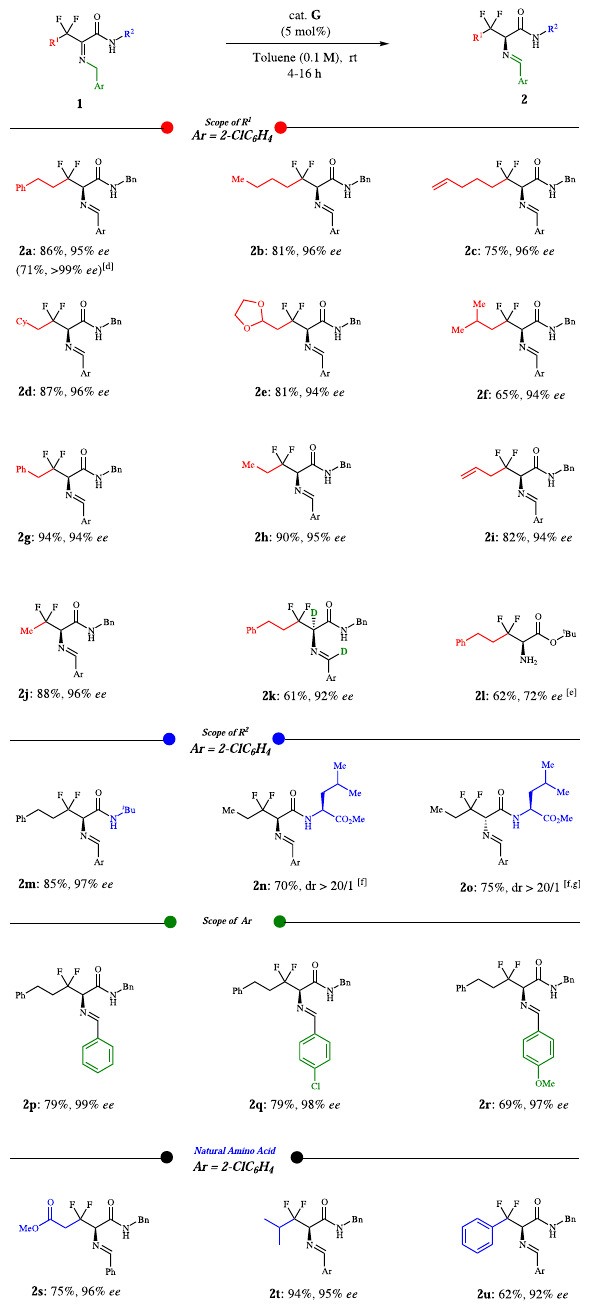
Fig. 3 Scope of β , β -di fl uorinated imines [a,b,c] . a Conditions: 1a (0.1 mmol), cat. G (5 mol%), toluene (1.0 mL), room temperature, 4 – 16 h. b Isolated